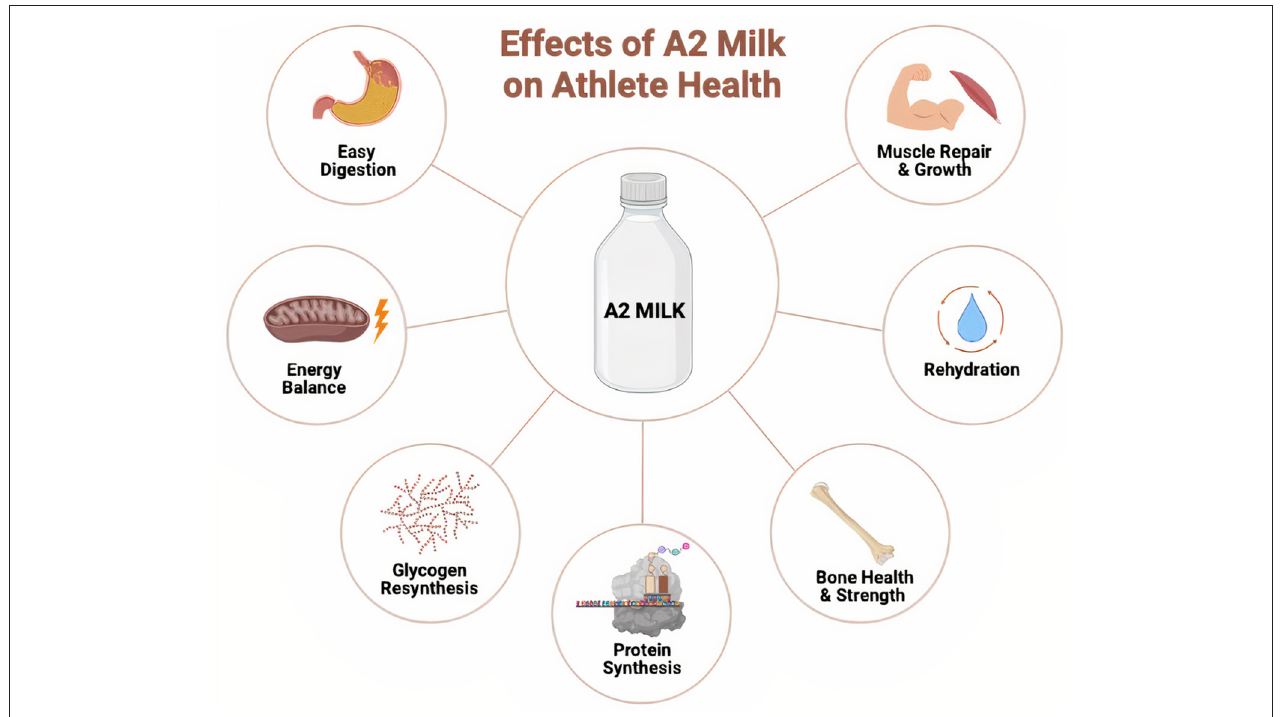
FIGURE 1 | Different possible effects of the consumption of A2 milk on athlete